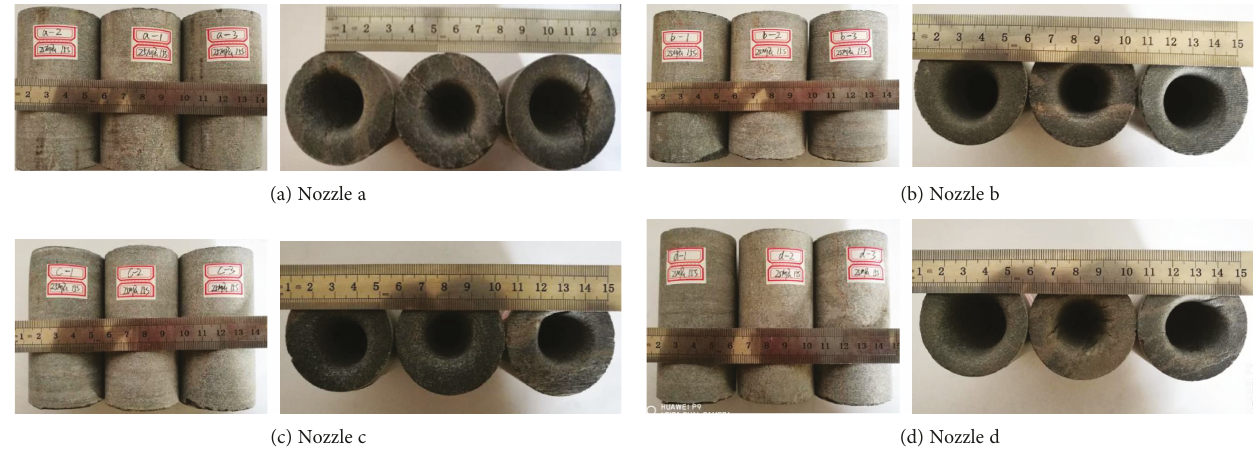
Figure 13: Erosion pit of rock.